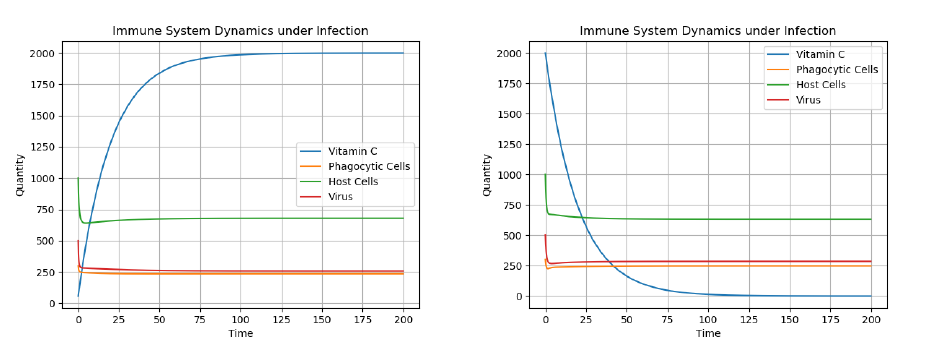
Figure 13. Dynamics under Chédiak-Higashi syndrome under Extreme Constant Infusion and Single Dose Vitamin C